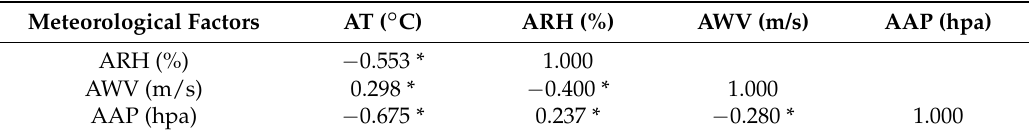
Table 5. Results of correlation analysis of the meteorological factors.